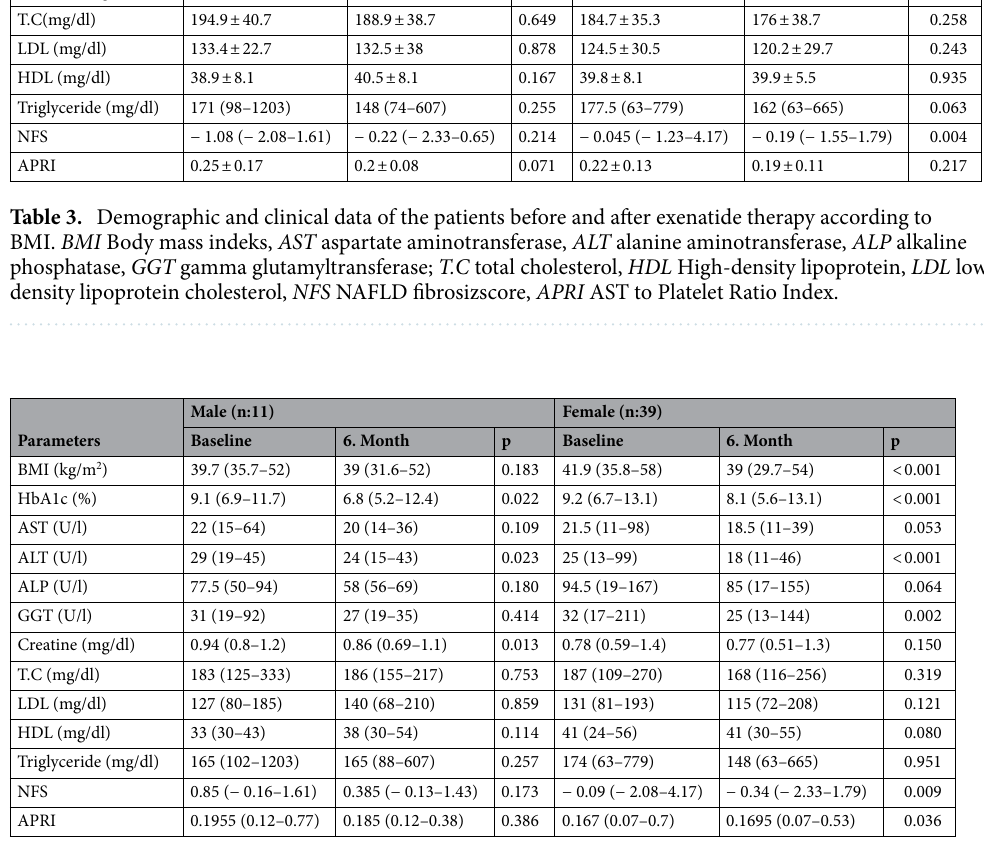
Table 4. Demographic and clinical data of the patients before and after exenatide therapy according to gender. BMI Body mass indeks, AST Aspartate aminotransferase, ALT Alanine aminotransferase, ALP alkaline phosphatase, GGT Gamma glutamyltransferase, T.C Total cholesterol, HDL High-density lipoprotein, LDL Low-density lipoprotein, NFS NAFLD fibrosiz score, APRI AST to Platelet Ratio Index.